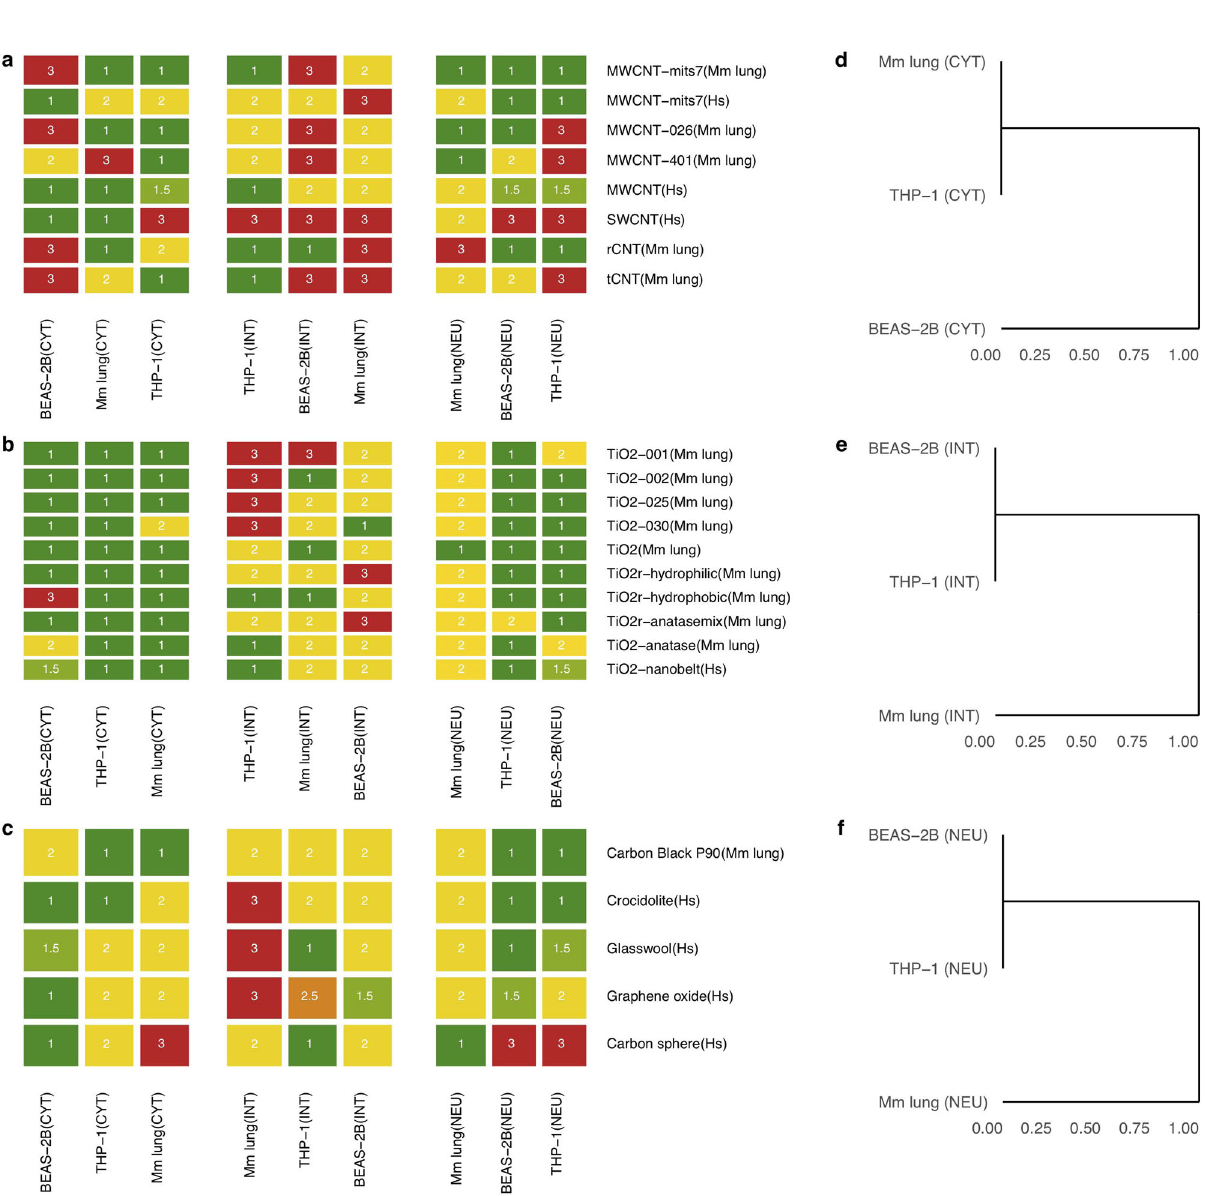
Fig. 4 Prediction results on transcriptome pro fi les from external datasets. Heatmaps showing the class label assigned to each external ENM exposure, and dendrograms highlighting the distance between predictions made by using different cell models. a Prediction results on single- and multi-walled carbon nanotubes. b Prediction results on different TiO 2 nanoparticles. c Prediction results on ENM types that were not included in the training set. d Dendrogram showing the distance between cell-based mRNA models selected for the classi fi cation task integrating different toxicity endpoints. e Dendrogram showing the distance between cell-based mRNA models selected for the cytotoxicity-related classi fi cation task. f Dendrogram showing the distance between cell- based mRNA models selected for the classi fi cation task de fi ned on the basis of the neutrophil count in BAL fl uid of mice. A color map was utilized to visually distinguish the predicted class labels: low (dark green), medium (yellow), and high (red) toxicity. In addition, since the predictions were summarized over the biological systems exposed to a given ENM, we reported the median value of these predictions and introduced two intermediate levels of toxicity: low to medium (light green) and medium to high